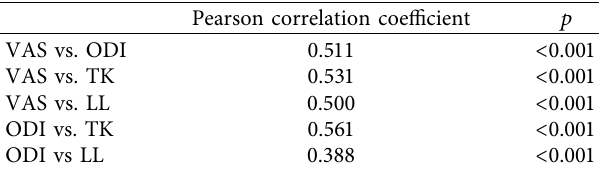
VAS, visual analog scale; ODI, Oswestry Disability Index; TK, thoracic kyphosis; LL, lumbar